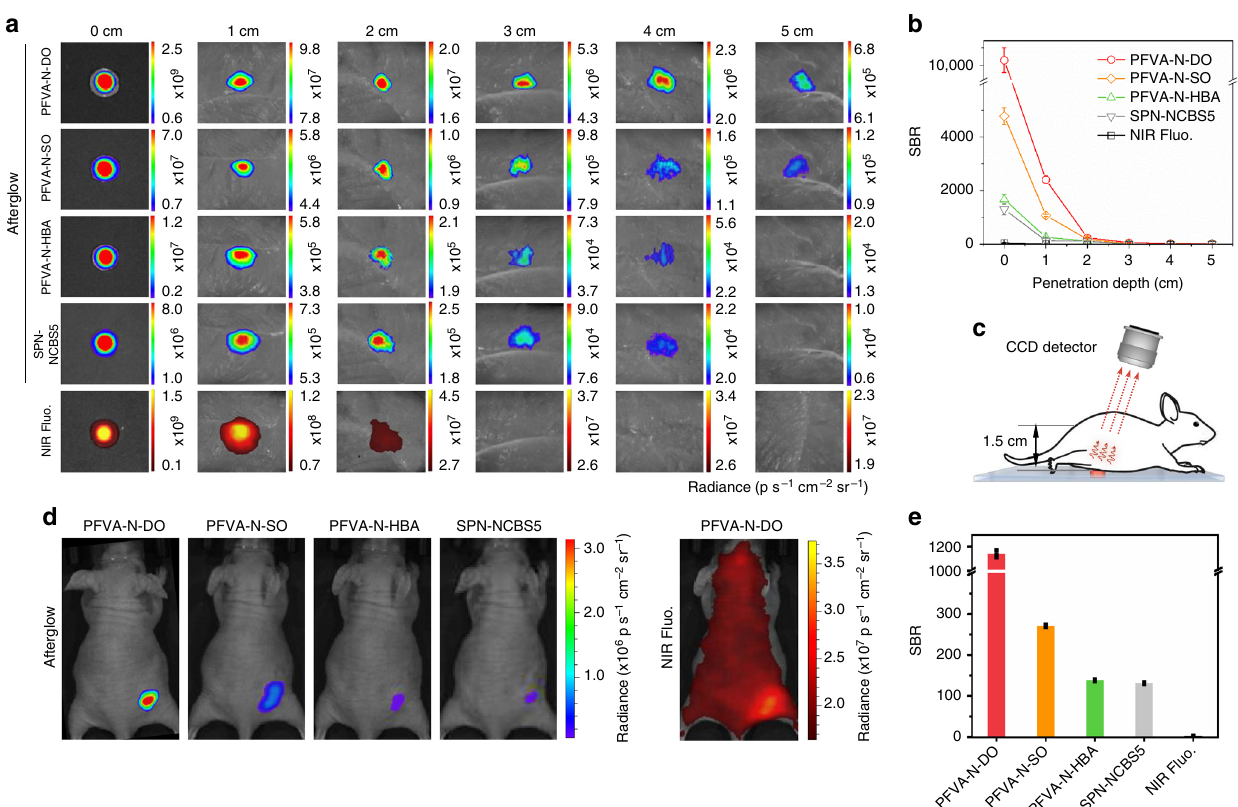
Fig. 4 Tissue penetration study of ALNPs. a Afterglow and NIR fl uorescence images of PFVA-based ALNPs ([PFVA] = 100 μ g mL − 1 , [DO], [SO], or [HBA] = 50 μ g mL − 1 , [NCBS] = 2.5 μ g mL − 1 , 50 μ L) and SPN-NCBS5 nanoparticles ([MEHPPV] = 100 μ g mL − 1 , [NCBS] = 5 μ g mL − 1 , 50 μ L) under different depths of chicken breast tissues. b SBRs of afterglow or fl uorescence images in ( a ) at different tissue depths. c Schematic illustration of optical imaging through a living mouse. Afterglow and NIR fl uorescence images of PFVA-based ALNPs or SPN-NCBS5 were captured after penetrating through a living mouse. CCD, charged coupled device. d Afterglow and fl uorescence images of PFVA-based ALNPs or SPN-NCBS5 nanoparticles penetrating through a living mouse. Concentrations of nanoparticles were identical to those in ( b ). e Quanti fi cation of the SBRs of afterglow or fl uorescence images in ( d ). Both the PFVA-based ALNPs and SPN-NCBS5 were pre-irradiated at 808 nm for 5 s (at 1 W cm − 2 ) before imaging. Fluorescence images were captured at 780 nm upon excitation at 710 nm. Error bars indicated standard deviations of three separate